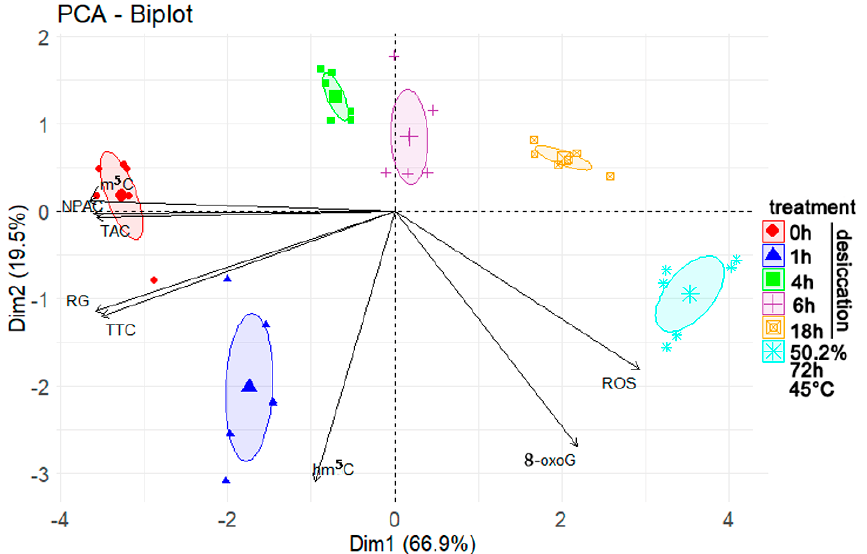
Figure 6. Results of principal component analysis (PCA) applied on the correlations of regrowth (RG), metabolic activity (TTC), ROS level, relative amount (%) of m 5 C, hm 5 C, 8-oxoG, total antioxidant capacity (TAC), non-protein antioxidant capacity (NPAC) in embryonic axes directly after desiccation or accelerated aging (72 h, 45 °C, MC of 50%). Ellipse confidence level = 0.95.